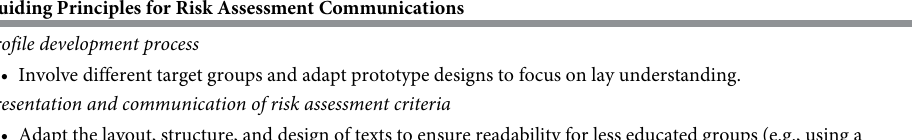
Table 1. Summary of guiding principles for developing risk assessment communications derived from the litera- ture